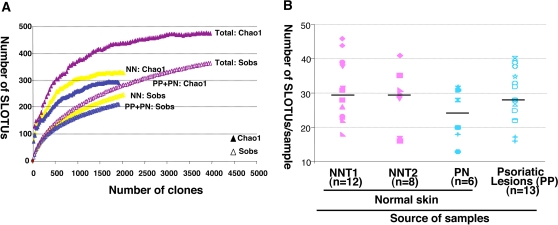
Diversity of bacterial species in 39 skin specimens from 12 subjects. Panel A. Collector's curves of SLOTU richness of pooled skin samples from six healthy subjects and six patients with psoriasis.Each curve reflects the observed (Sobs) or estimated (Chao1) richness values obtained in 3 different groups of 16S rDNA clones. PP+PN indicates the 1,925 (1,314 from psoriatic lesion and 611 from uninvolved skin, respectively), clones from six patients with psoriasis, added to the data set in an arbitrary order. NN includes 2,038 clones from healthy persons reported in a prior study [11]. Overall, the sequences detected from the (Total) 39 human skin specimens from these studies represent 366 different SLOTUs, whereas the Chao1 score estimates that the skin bacterial biota contains 476 SLOTUs. Based on this prediction, Good's estimator of coverage is 96.9%. Panel B. Diversity at the species level. The 20 samples from 6 healthy subjects (pink) and 19 samples from 6 patients with psoriasis (blue) are indicated by the color designations. NNT1 (n = 12) represents left and right forearm skin for six subjects, NNT2 (n = 8) represents the resampling of four subjects 8–10 months later [11]. PN (n = 6) represents uninvolved skin from six patients with psoriasis. The samples from healthy subjects and from uninvolved skin from psoriatic patients are indicated with solid symbols, and the samples from psoriatic lesions are indicated with open symbols. All samples from the same subject are indicated by the same symbol. For each group, the horizontal line indicates the median of the number of SLOTU.